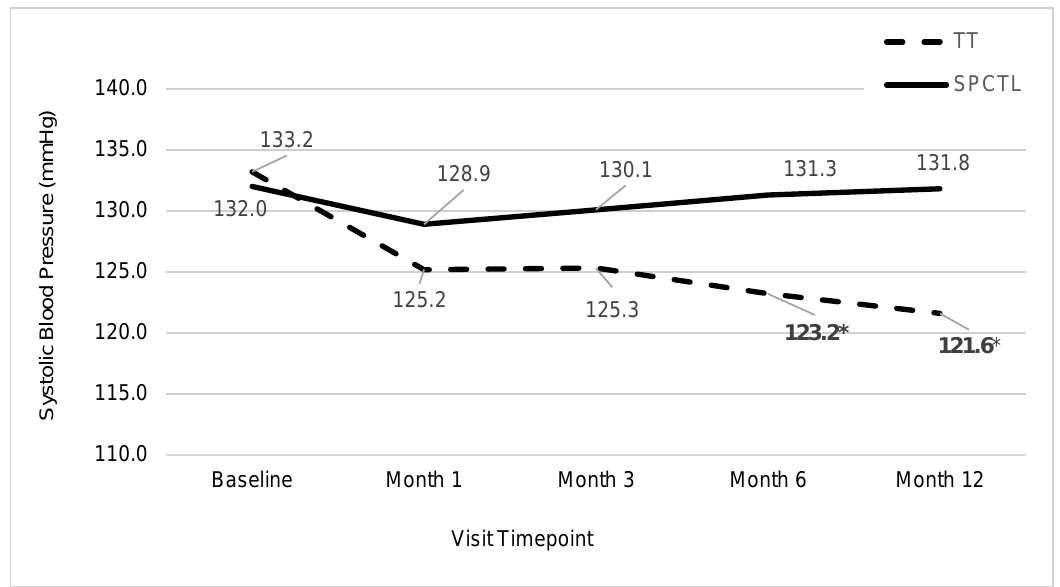
Figure 3. Average Systolic Blood Pressure by Group and Visit.